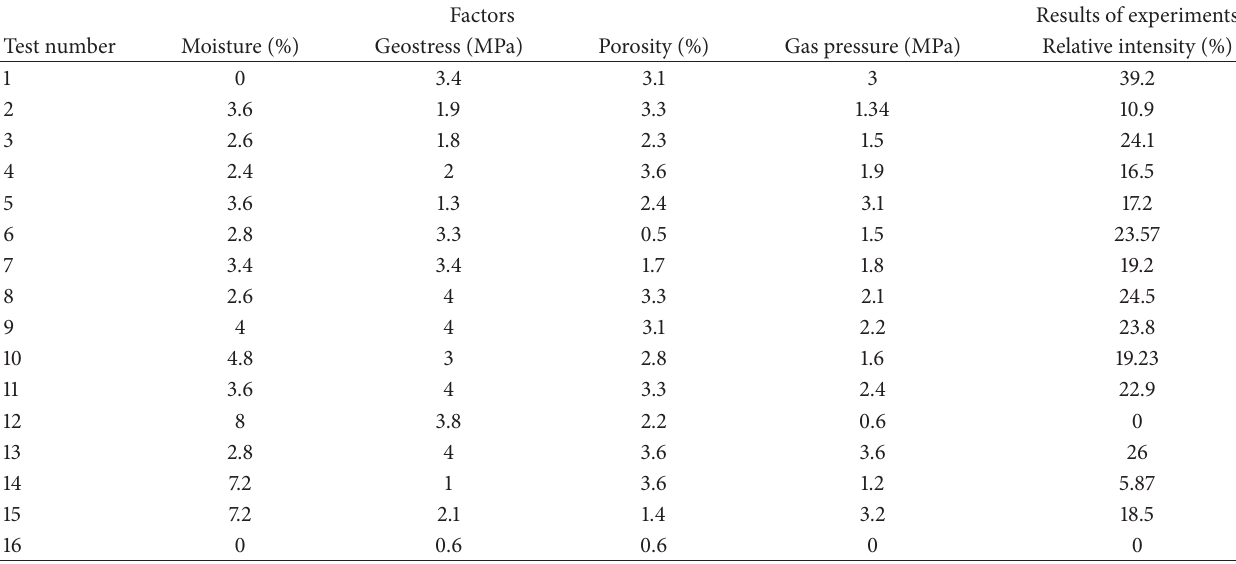
Table 3: Coupled factors and relative intensity of outburst in coal and gas.